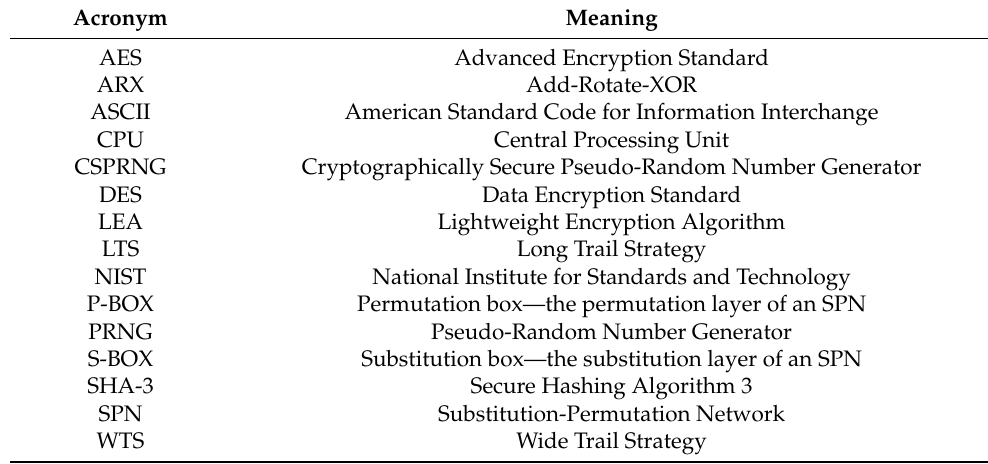
Table 1. Acronyms used in the paper.